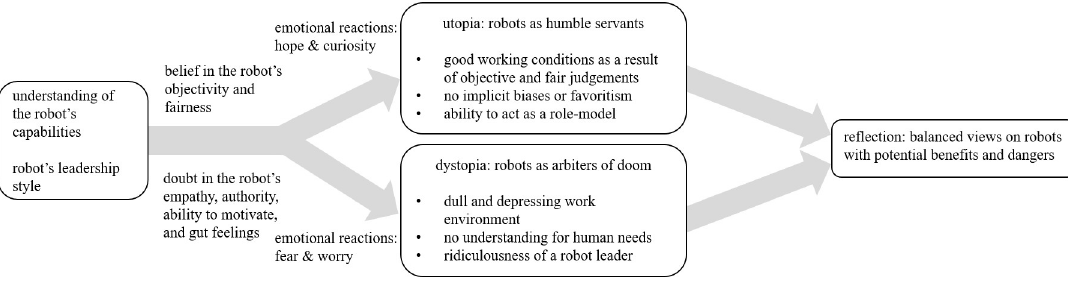
Fig 3. Synthesized overview of the participants’